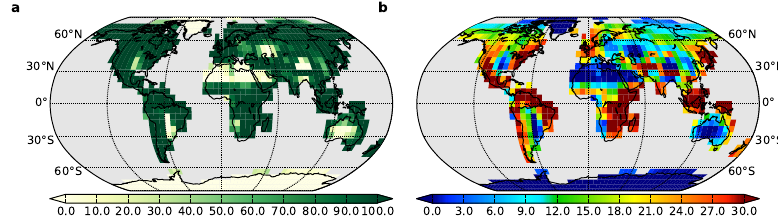
Figure 3. Distribution of (a) total vegetation cover (%) and (b) total carbon content (kgCm − 2 ).